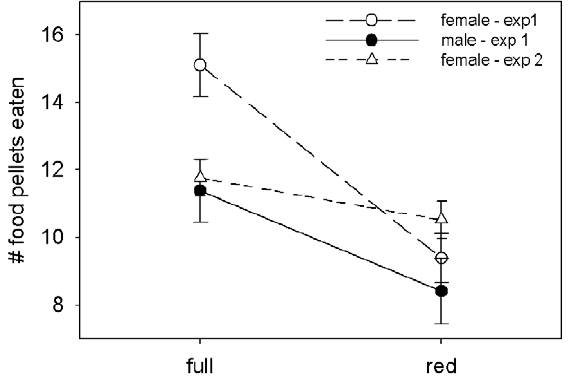
Figure 3. Foraging performance under experimental lighting conditions. Mean 6 S.E. number of food pellets eaten by male and female house finches in experiment one, and by female house finches in experiment two under high-contrast full-light vs. low-contrast red- light conditions.